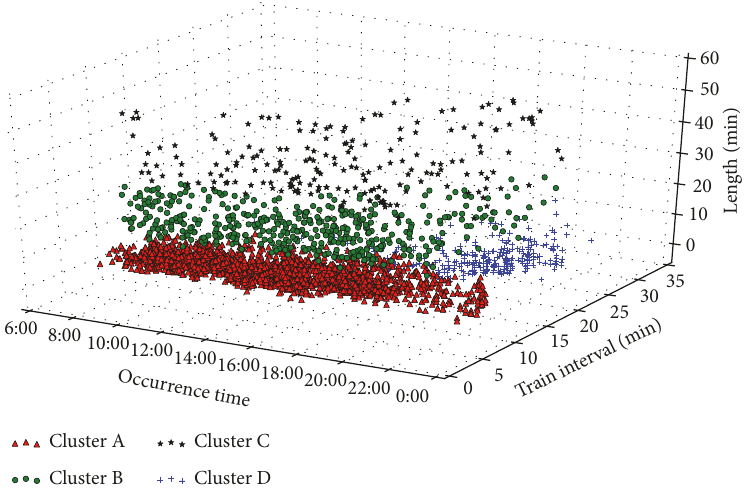
Figure 6: Spatial distribution of each disturbance cluster. Table 3: Statistics of NAT and